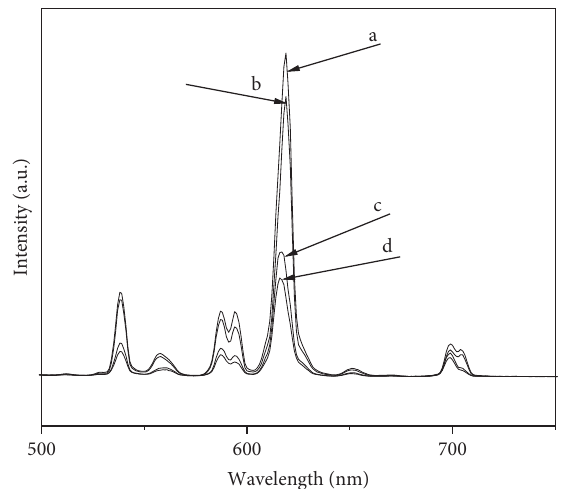
Figure 7: Emission spectra of YVO 3+ produced through hydrothermal treatment with different pH end values: (a) 13.0, (b) 12.0, 4 :(5%) Eu (c) 11.0, and (d) 8.0 under the excitation of 310nm at room temperature.